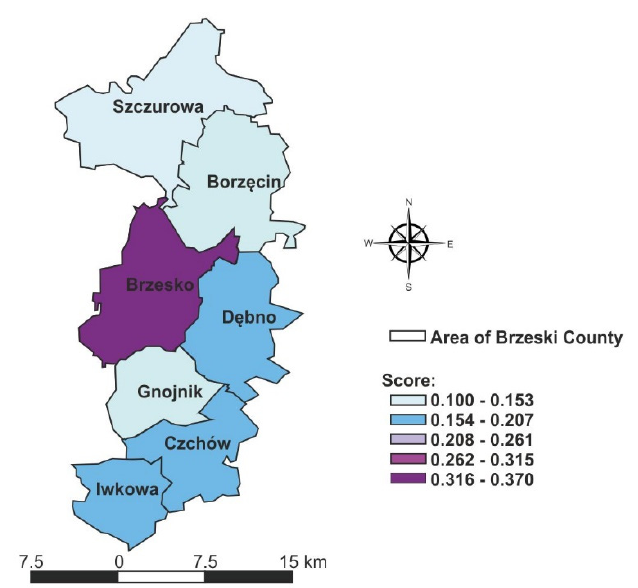
Figure 4. The communes’ composite scores in terms of attractiveness for tourists.